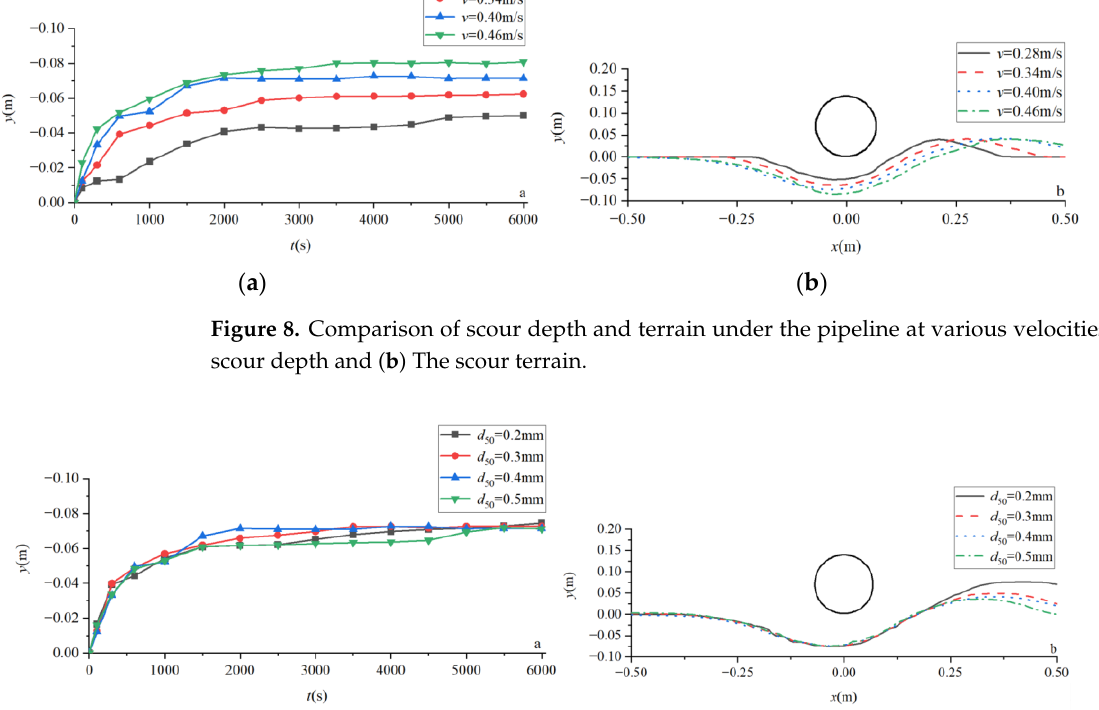
Figure 8. Comparison of scour depth and terrain under the pipeline at various velocities. ( a ) The scour depth and ( b ) The scour terrain.